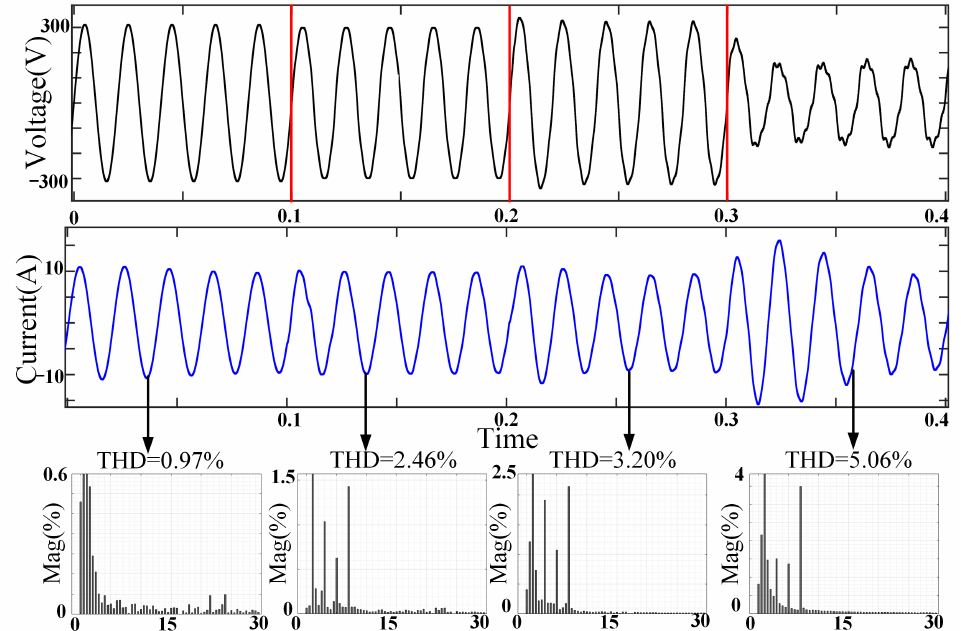
Figure 12. The grid-connected current when the grid environment